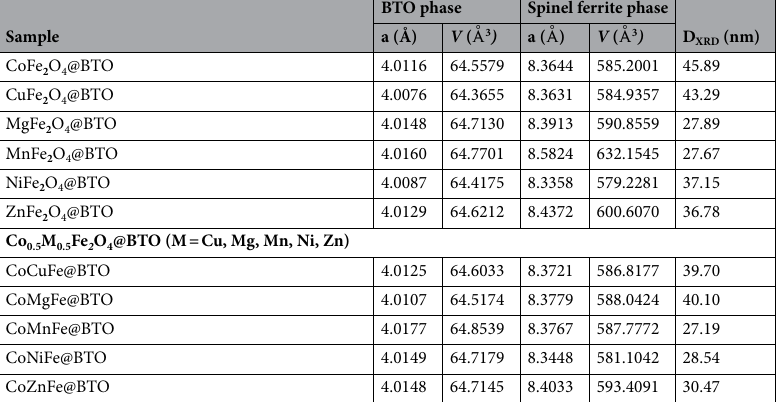
BTO phase Spinel ferrite